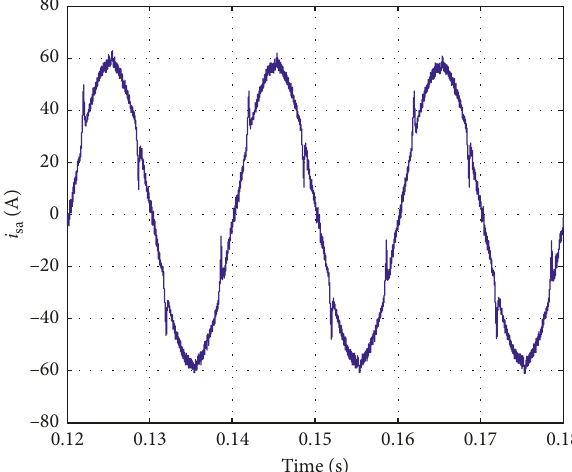
Figure 13: Waveform of source current using PI controller.